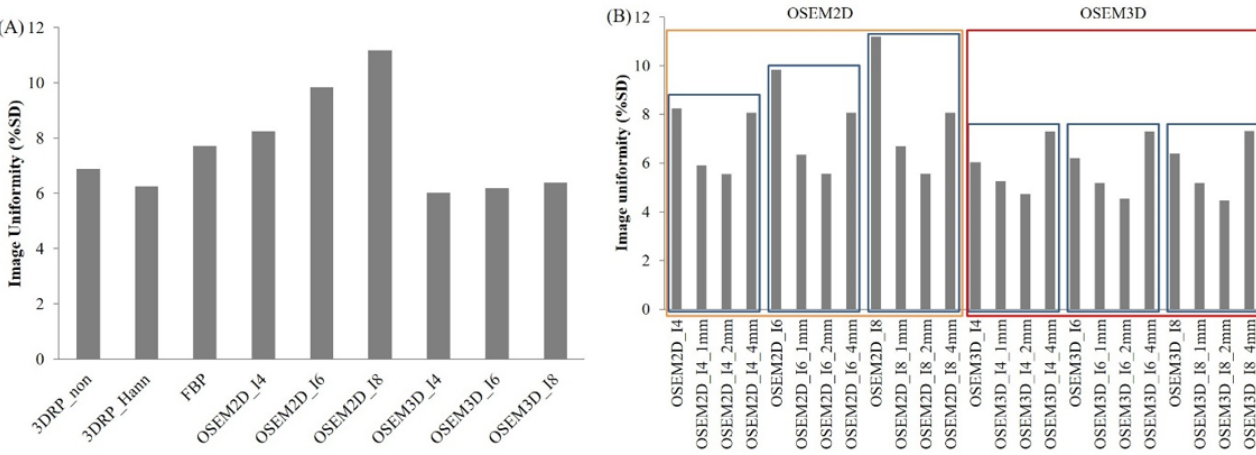
Figure 3. The uniformity of images was compared by %SD in uniformity area of the NEMA NU-4 mouse image quality phantom. ( A ) The uniformity of 3DRP and OSEM3D was higher than that of FBP. The uniformity of OSEM2D was lower than that of FBP. In iterative reconstruction methods, image uniformity decreased with increasing number of iterations. ( B ) In the iterative reconstruction methods (OSEM2D and OSEM3D), the image uniformities were compared by post- Gaussian filter effect. The image uniformity increased with the use of a Gaussian filter of 1 or 2 mm. However, the image uniformity decreased with the use of a Gaussian filter of 4 mm.